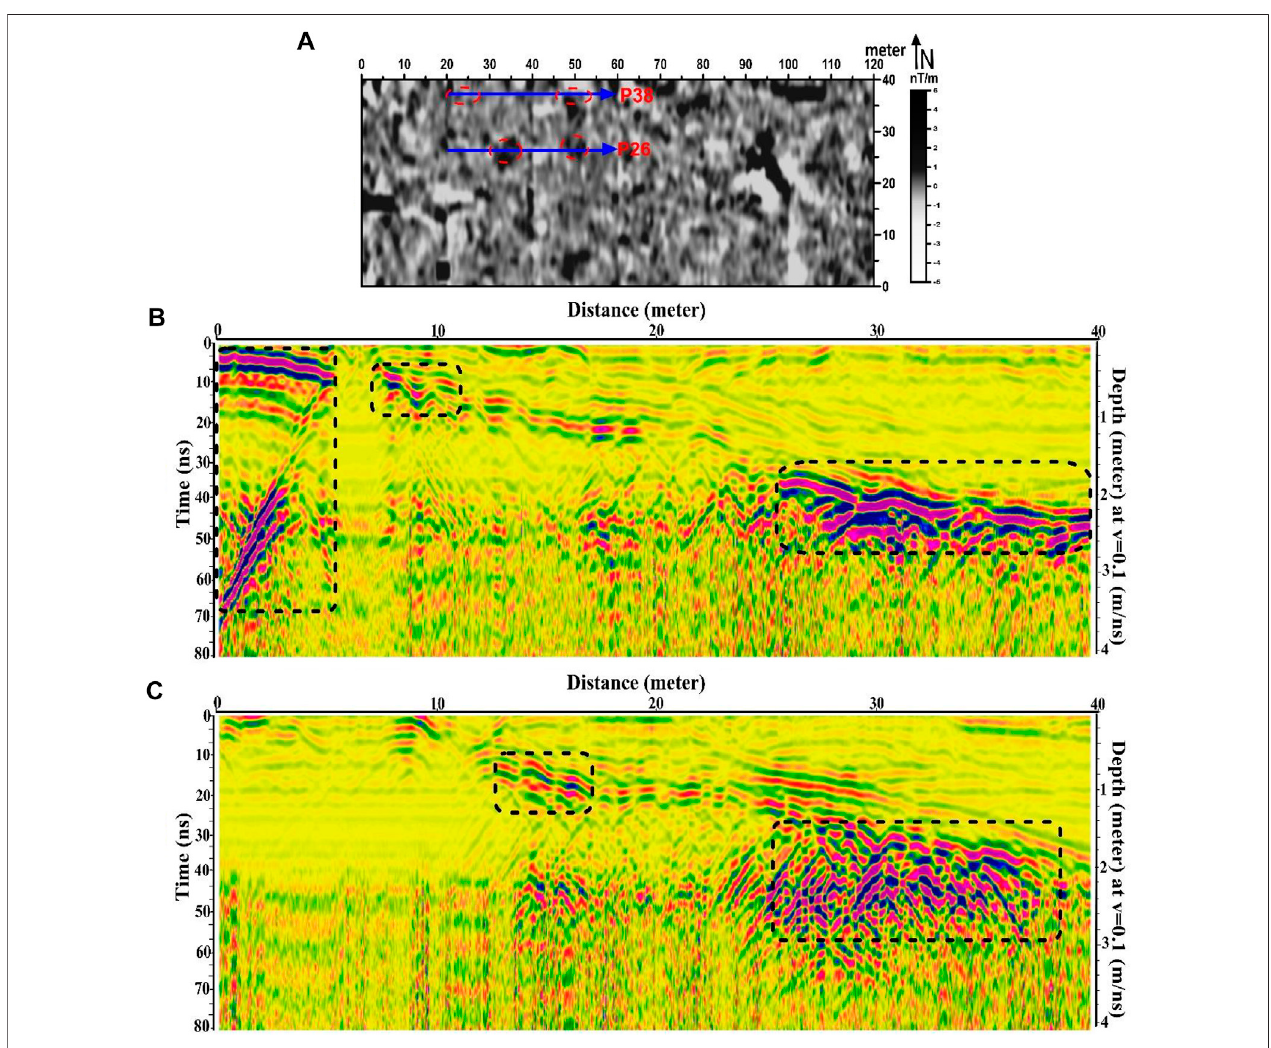
FIGURE 7 | (A) Magnetic image of site (B) shows the location of the GPR pro fi les (P26 and P38). (B) GPR display of pro fi le 26. (C) GPR display of pro fi le 38.